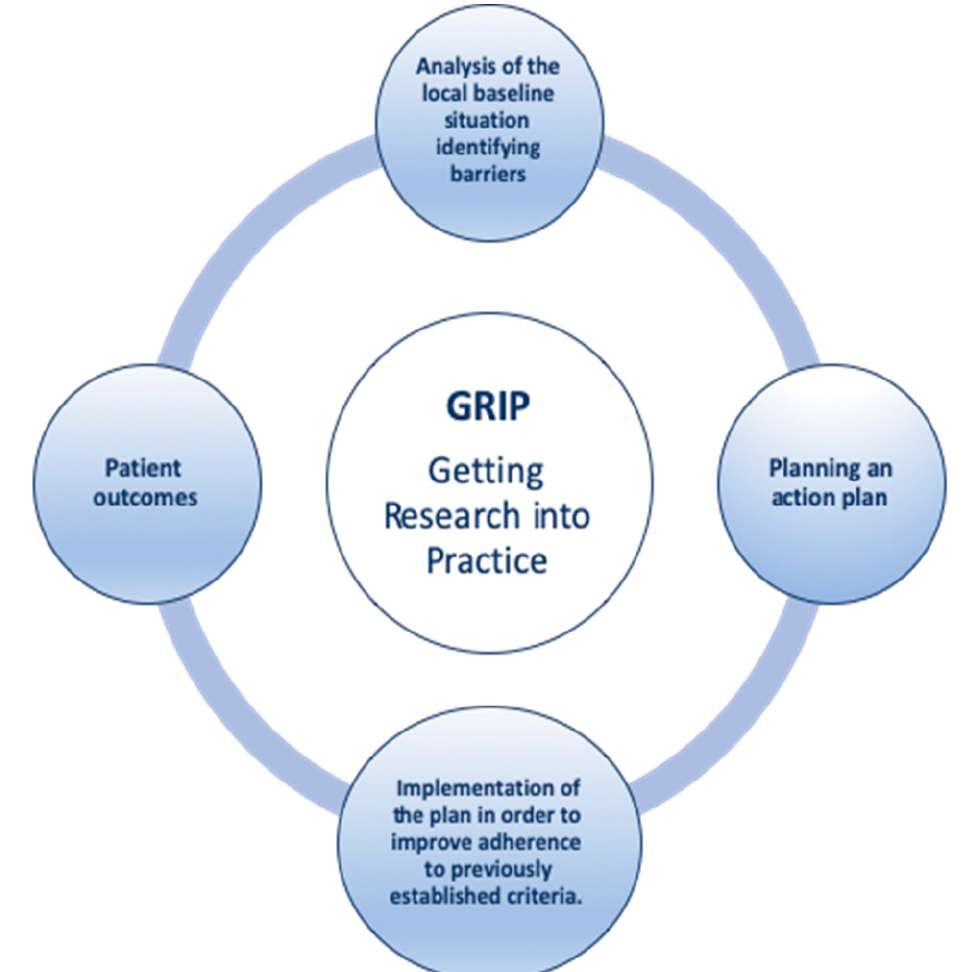
Figure 1. GRIP model (Getting Research Into Practice) [21] .